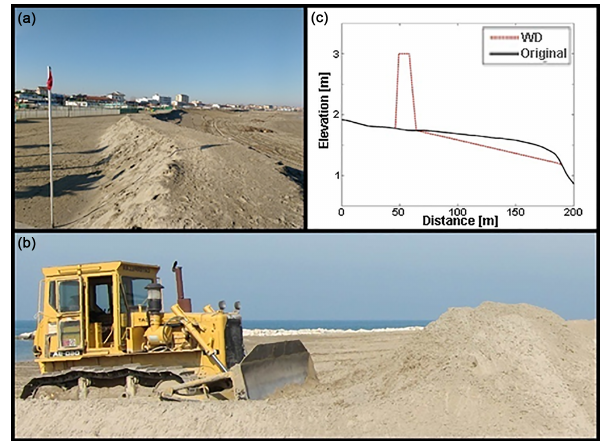
Figure 6. Artificial winter dunes in Emilia-Romagna: (a) winter dune in Porto Garibaldi (Comacchio, Italy); (b) building of a winter dune by beach scraping at Lido di Dante (Ravenna, Italy) (Harley, 2014); (c) representative model profiles at Lido di Spina north (orig- inal: black solid line; with winter dune measure: red dashed line).